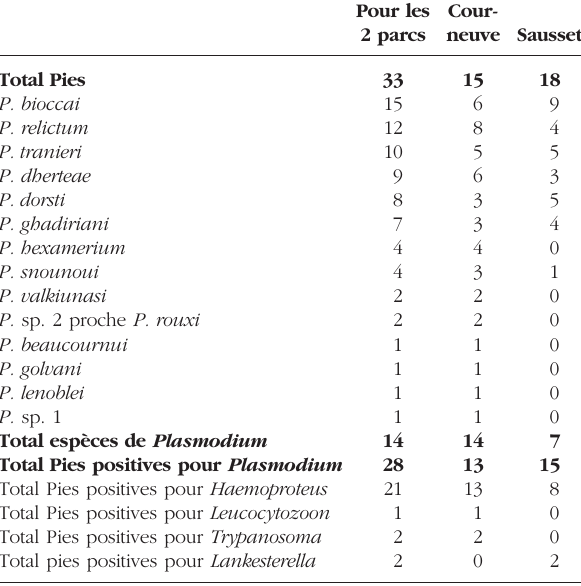
Tableau III. – Fréquence des différentes espèces de Plasmodium et des autres hématozoaires chez les Pies des deux